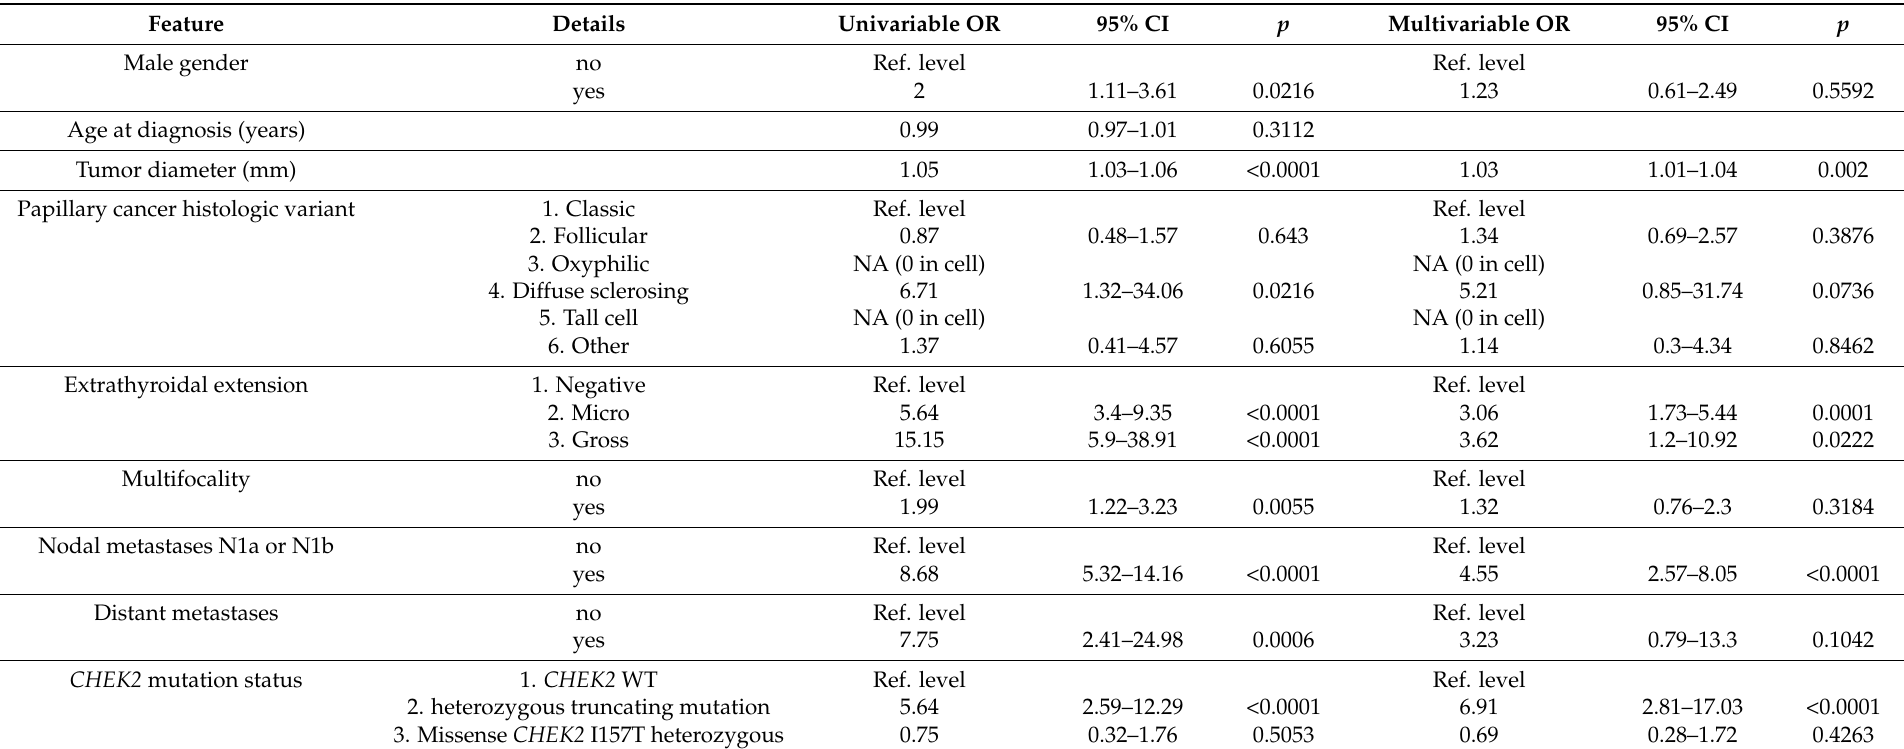
Table 4. Risk factors for vascular